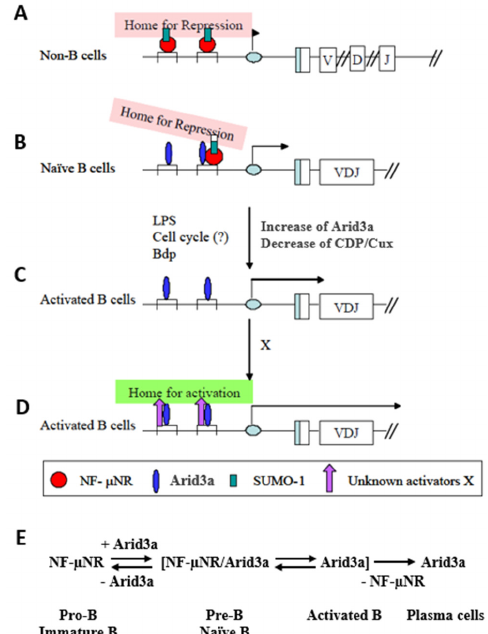
Figure 9. Hypothetical function of Arid3a in regulating IgH transcription through 5 ′ MARs. ( A ) IgH V H -associated promoter region may be sequestered within a sub-nuclear region(s) in which most transcription activities are repressed in non-B cells; ( B ) The interaction of Arid3a with CDP/Cux may change the DNA binding affinity of the NF- μ NR complex and/or increase the accessibility of other components which may comprise the Arid3a complex. These changes in NF- μ NR may alter the complex such that it can dissociate from MARs; ( C ) Activation of the B cells increases the affinity of Arid3a for both MARs, allowing the IgH promoter to be liberated from the repressive region by displacement of NF- μ NR; ( D ) As cells become more activated and move toward terminal differentiation, the Arid3a complex may change its components so as to re-localize the IgH promoter to a euchromatic sub-nuclear region; ( E ) Hypothesized equilibrium of Arid3a and NF- µ NR during B cell